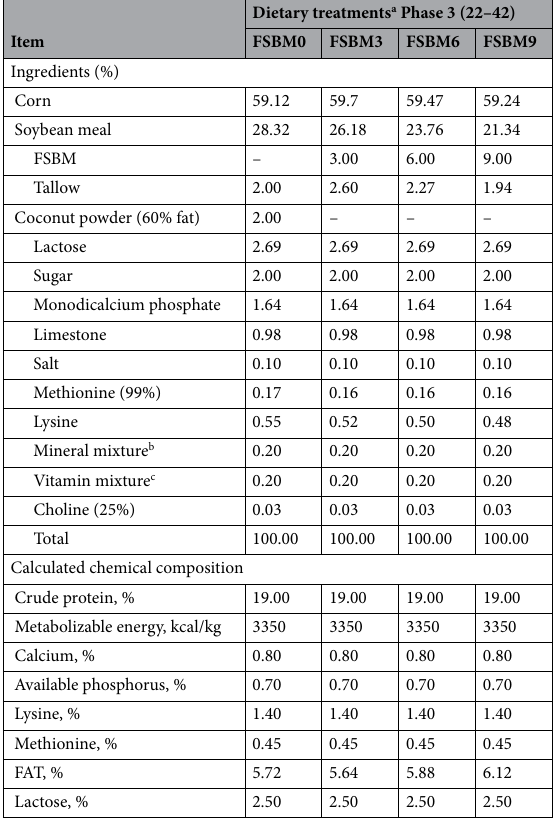
Table 4. Composition of weaning pig diets (as fed-basis). a FSBM0, FSBM3, FSBM6 and FSBM9 diets were made by substituting fermented soybean meal for 0, 3, 6 and 9% soybean meal. b Provided per kg diet: Fe, 100 mg as ferrous sulfate; Cu, 17 mg as copper sulfate; Mn, 17 mg as manganese oxide; I, 0.5 mg as potassium iodide; and Se, 0.3 mg as sodium selenite. c Provided per kilograms of diet: vitamin A, 10,800 IU; vitamin D3, 4000 IU; vitamin E, 40 IU; vitamin K3, 4 mg; vitamin B1, 6 mg; vitamin B2, 12 mg; vitamin B6, 6 mg; vitamin B12, 0.05 mg; biotin, 0.2 mg; folic acid, 2 mg; niacin, 50 mg; D-calcium pantothenate, 25